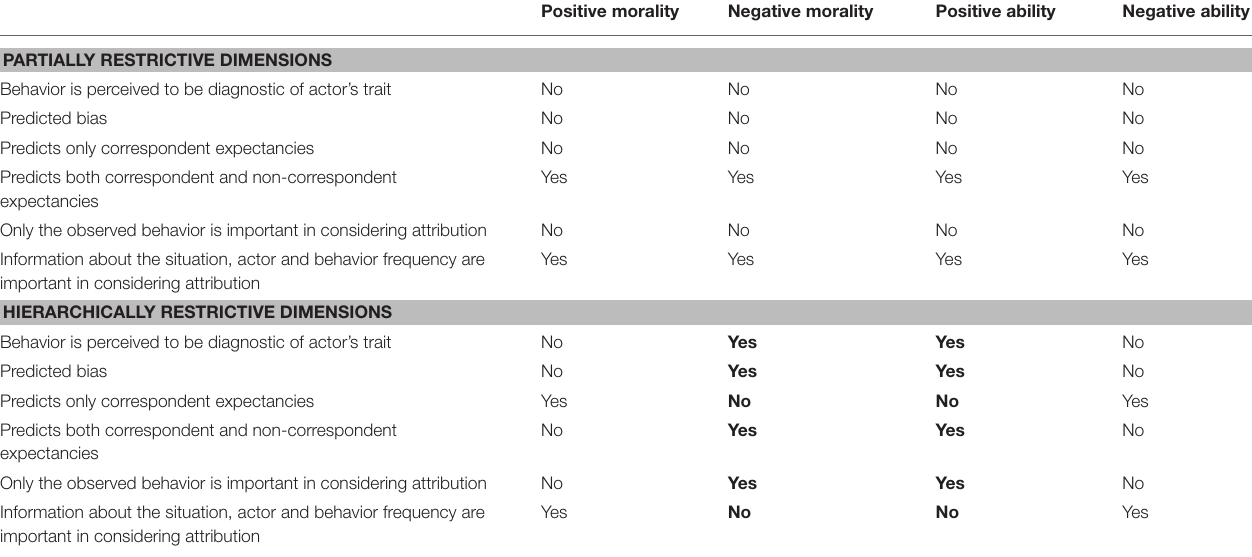
Positive morality Negative morality Positive ability Negative ability